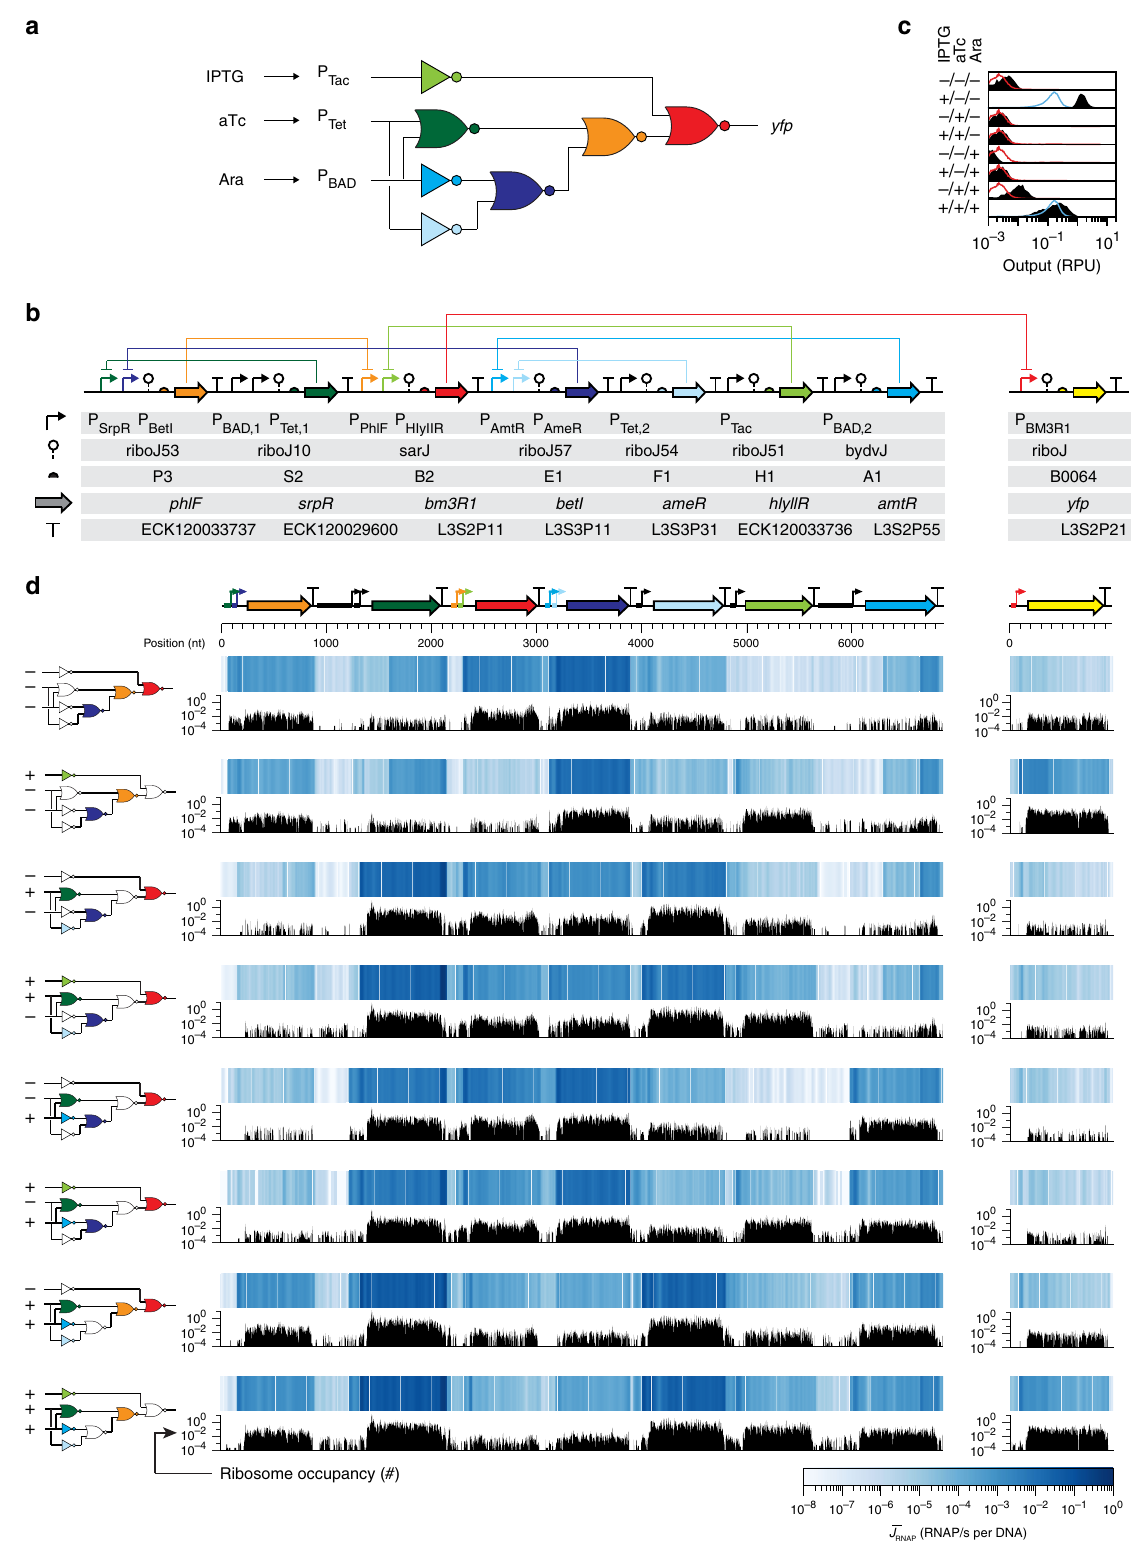
Fig. 1 Genetic circuit characterization using RNA-seq and ribosome pro fi ling. a Wiring diagram of the model circuit is shown. The colors correspond to the repressors used for each gate. b Genetic parts for the genetic circuit (left) and output promoter (right), carried on different plasmids (Supplementary Fig. 1 and Supplementary Table 5). c The measured response of the circuit output to different combinations of inputs (1 mM IPTG, 2 ng/ml (4.32 nM) aTc, and 5 mM Ara). The black distributions are experimental measurements (Methods) compared to Cello predictions (blue if ON, red if OFF). d The RNAP fl ux across the circuit is shown (blue) with the ribosome occupancies (black). Each circuit state is shown, marked by the diagram (thick black lines indicate corresponding wires that are ON; gates are colored if that repressor is being expressed). The conversions of RNA-seq and ribosome pro fi ling data to absolute units are described in the Methods. Source data are provided as a Source Data fi